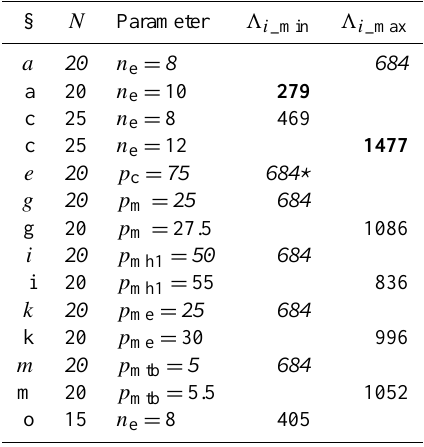
Table 9. Minimum ( (cid:51) i _min ) and maximum ( (cid:51) i _max ) numbers of GA iterations needed to reach (cid:56) max (only experiments with (cid:56) max = 1 are considered). In the first column, the letters refer to Fig. 19. In bold, the best and worst experiments. An asterisk marks the experiment e , in which (cid:56) max was reached only for p c = 75. In italics, the combinations of parameters of the benchmark experi- ment (cf. Table